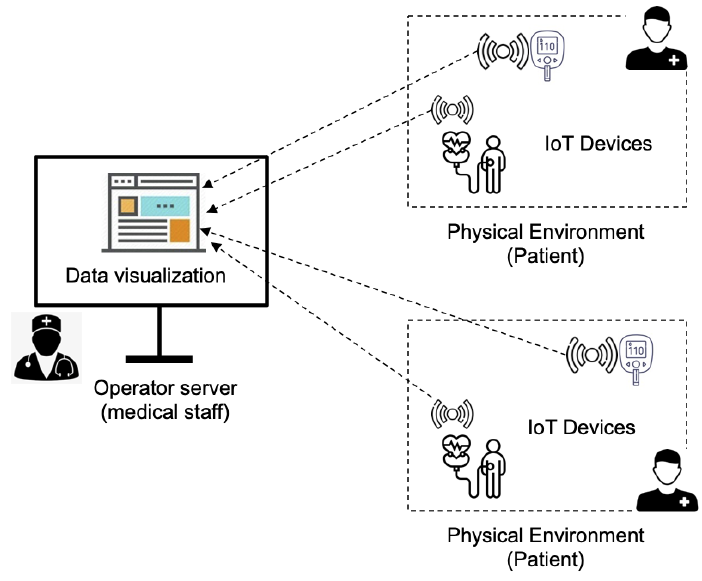
Figure 1. Overview of an IoT eHealth system for patient